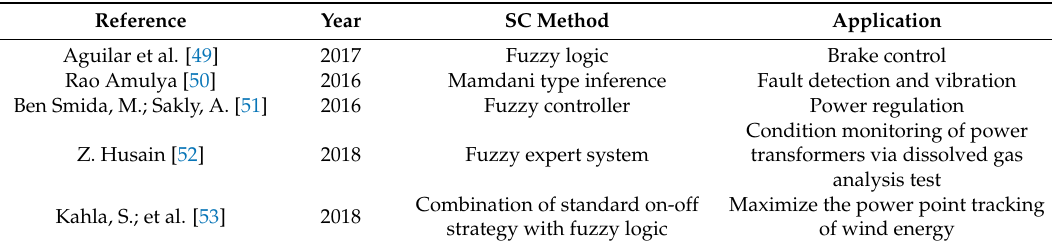
Table 1. Simple fuzzy systems in rotating the electrical